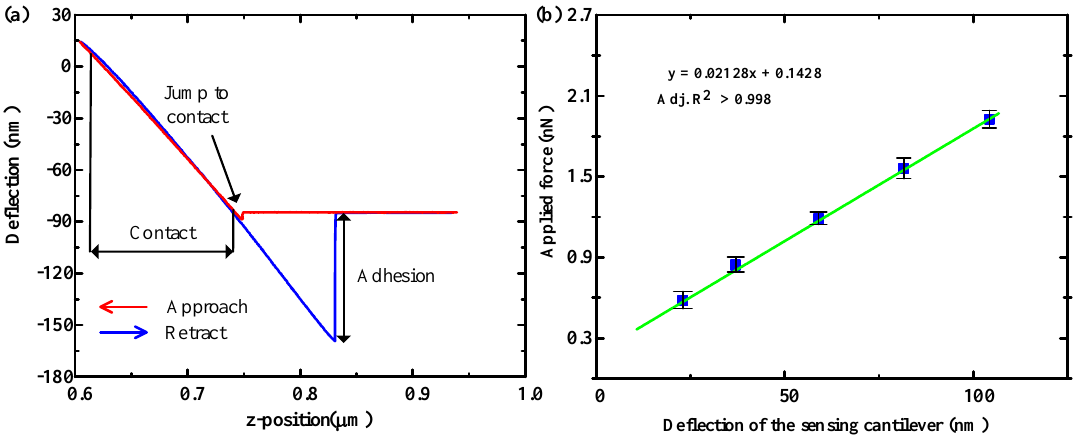
Figure 5. ( a ) The relationship curve between the deflection displacement of the microcantilever and the AFM tip position change under the AFM load force. ( b ) The linear correlation of the relationship between the load force on a microcantilever and its deflection displacement.